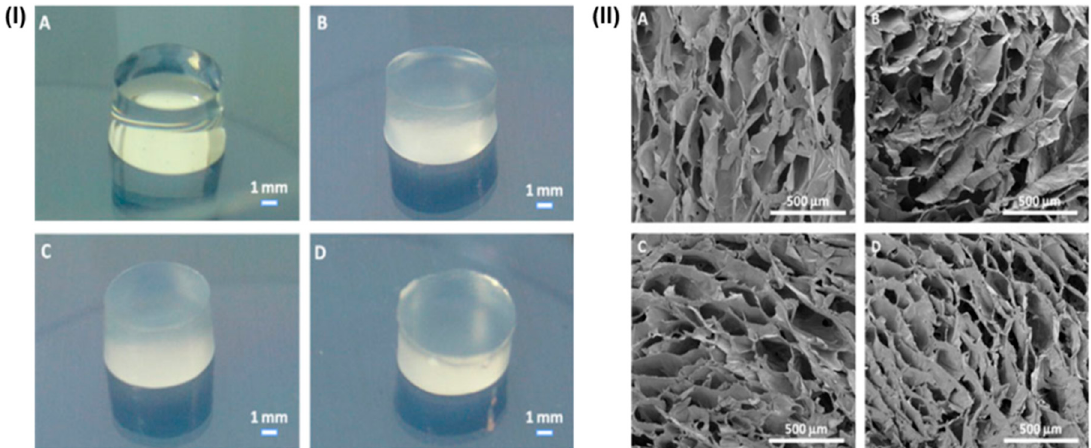
Figure 3. Digital images ( I ) and SEM images ( II ) of GG-based hydrogel disks: non-crosslinked GG ( A ); ionic crosslinked GGMA disks ( B ); MBF (0.1% w / v ) photocrosslinked GGMA disks at 366 nm ( C ); and HHMPP (0.05% w / v ) photocrosslinked GGMA disks at 240–300 nm ( D ). Reproduced with the permission from [162]. Copyright 2010, Elsevier.